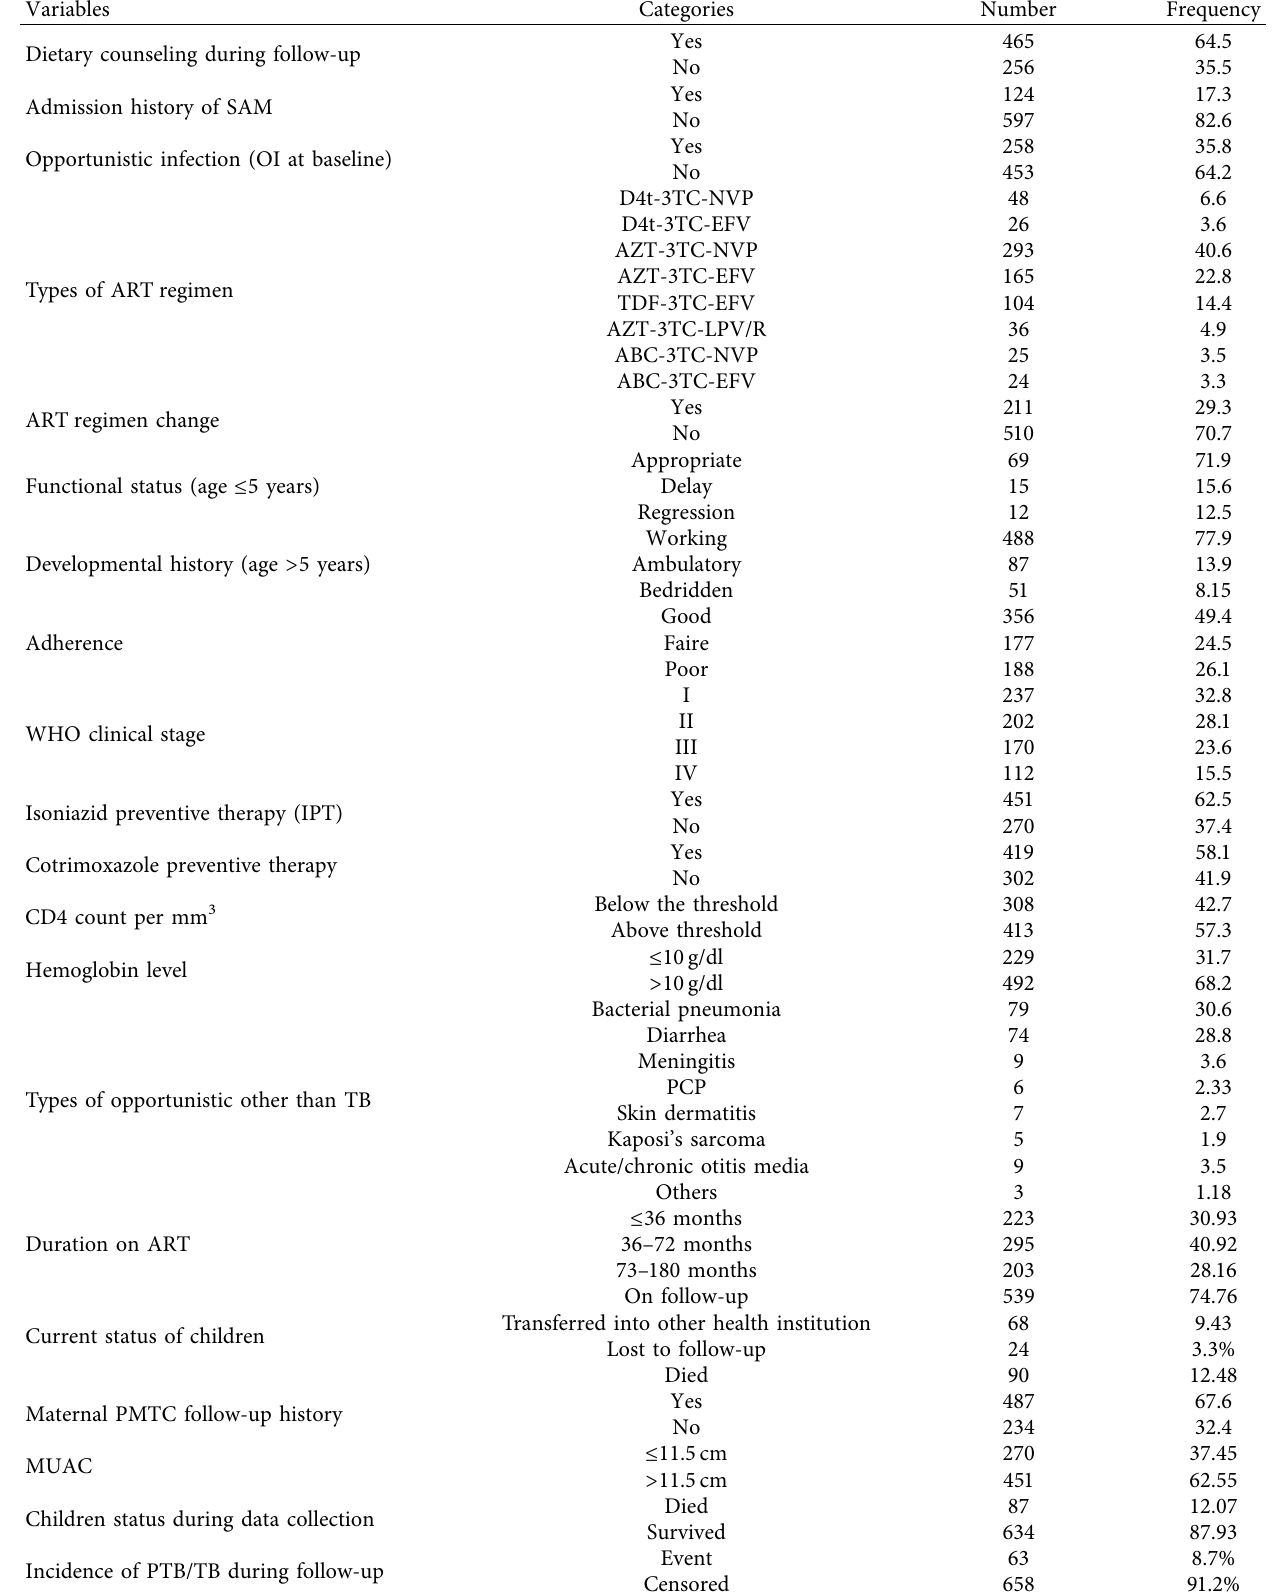
Table 2: Clinical and hematologic characteristics of seropositive children attending ART care in selected public health facilities ( N �